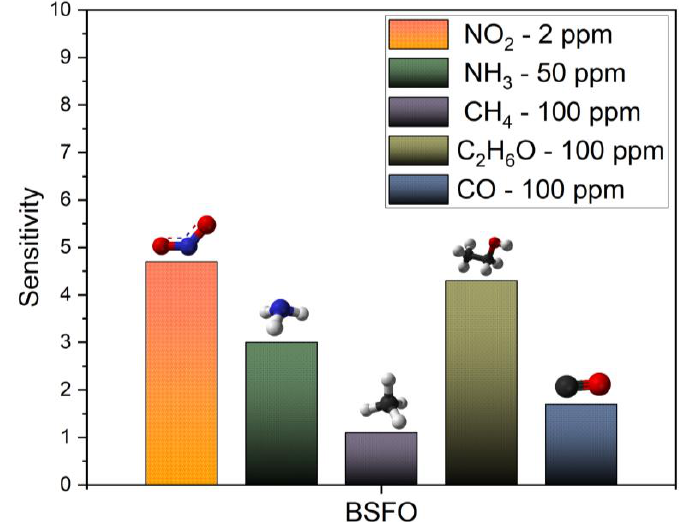
Figure 9. Cross-sensitivity test for BSFO at 260 °C.